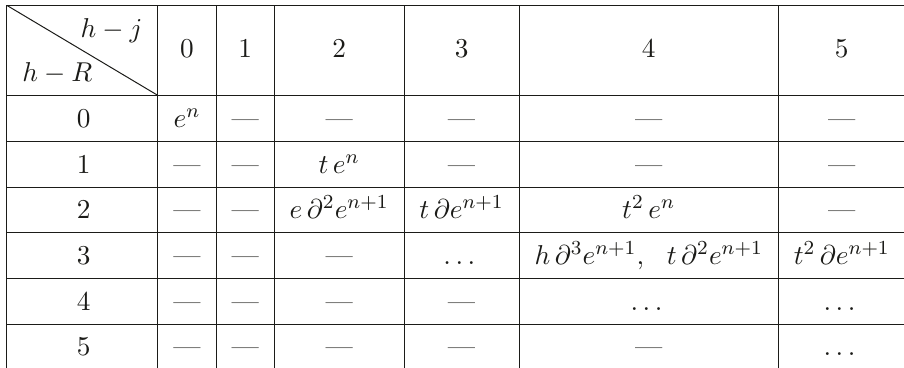
. . . ( sl (2)), organized according to the two 3 , and we use the notation t = T Sugawara . ∞